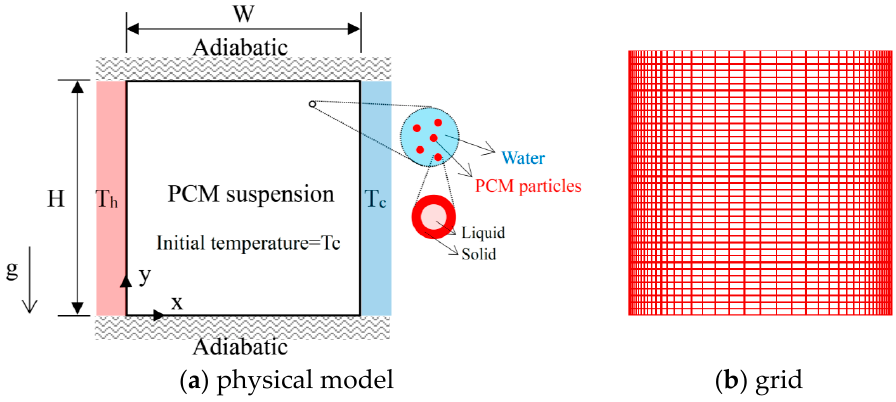
Figure 1. Schematic diagrams of ( a ) the physical model and ( b ) grid. In the mixed continuum formula for the buoyancy-driven circulation flow of the PCM suspension, the simplified assumptions used are as